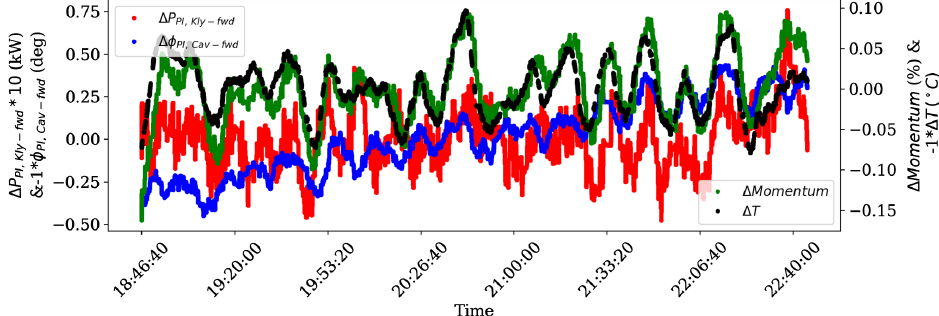
FIG. 45. Slower drifts in photoinjector power and amplitude (normalized) and temperature, and the associated variation in the beam momentum. The data were smoothed using a moving Gaussian window with 2 s